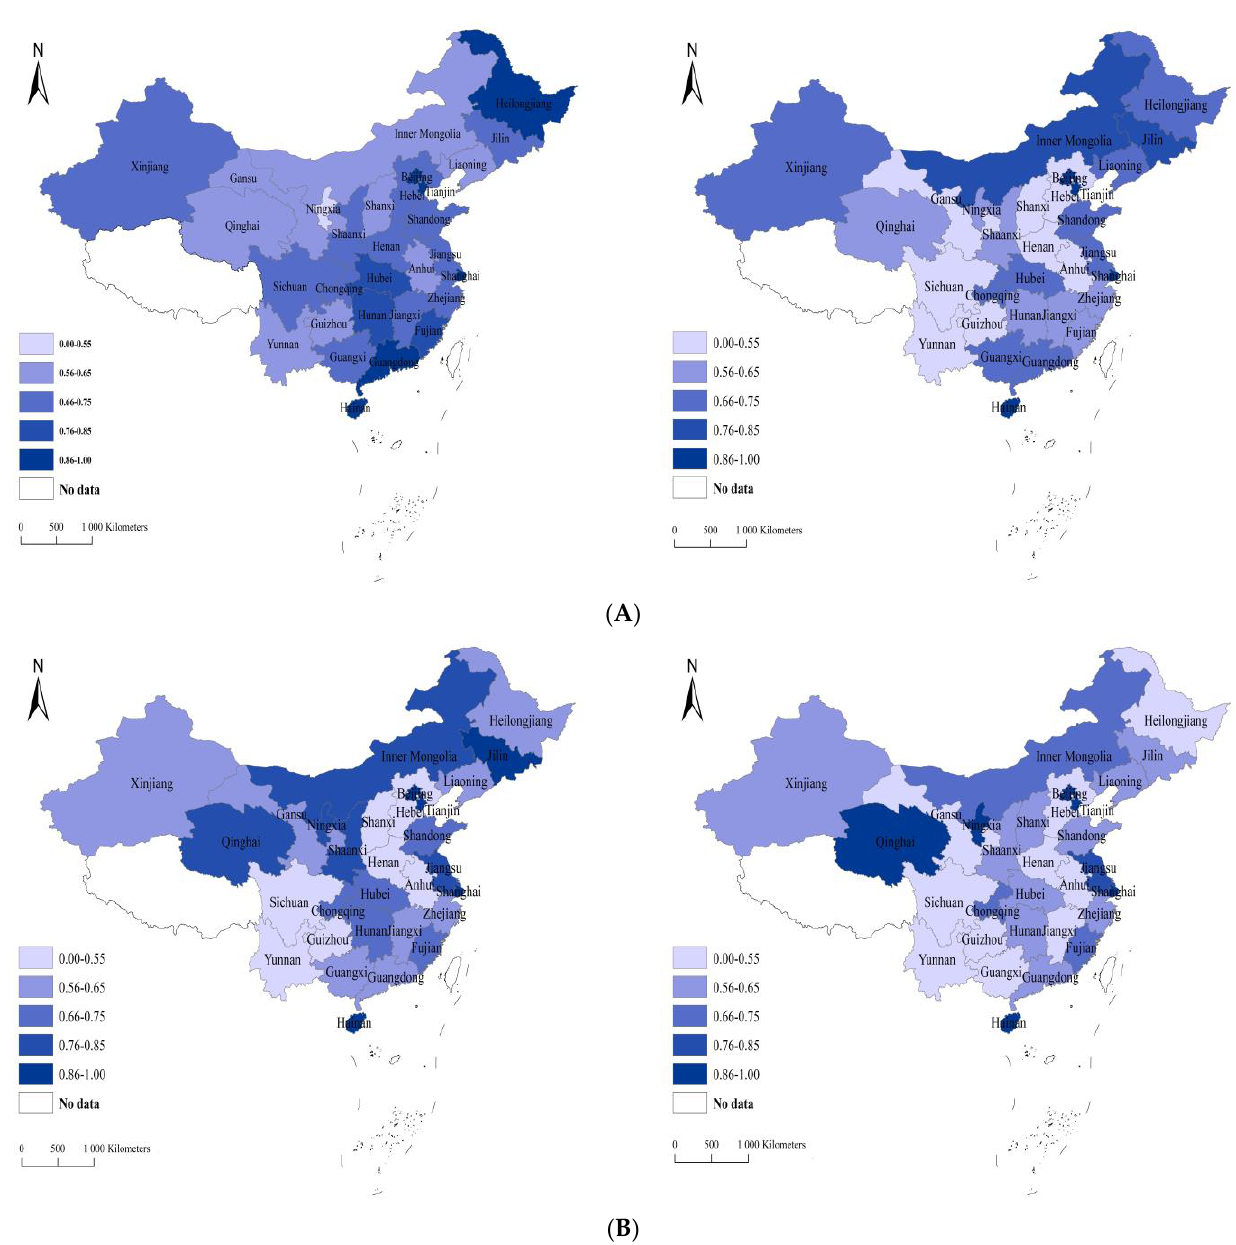
Figure 3. Distribution of China’s provincial IGGE. ( A ) China’s provincial IGGE in 2006 and China’s provincial IGGE in 2011. ( B ) China’s provincial IGGE in 2016 and China’s provincial IGGE in 2020.